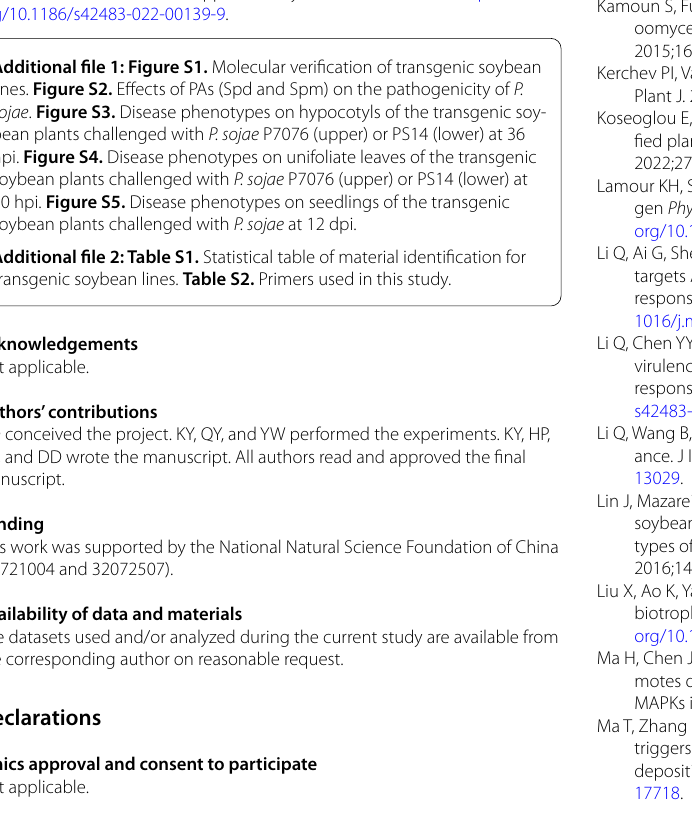
hpi. Figure S4. Disease phenotypes on unifoliate leaves of the transgenic soybean plants challenged with P. sojae P7076 (upper) or PS14 (lower) at